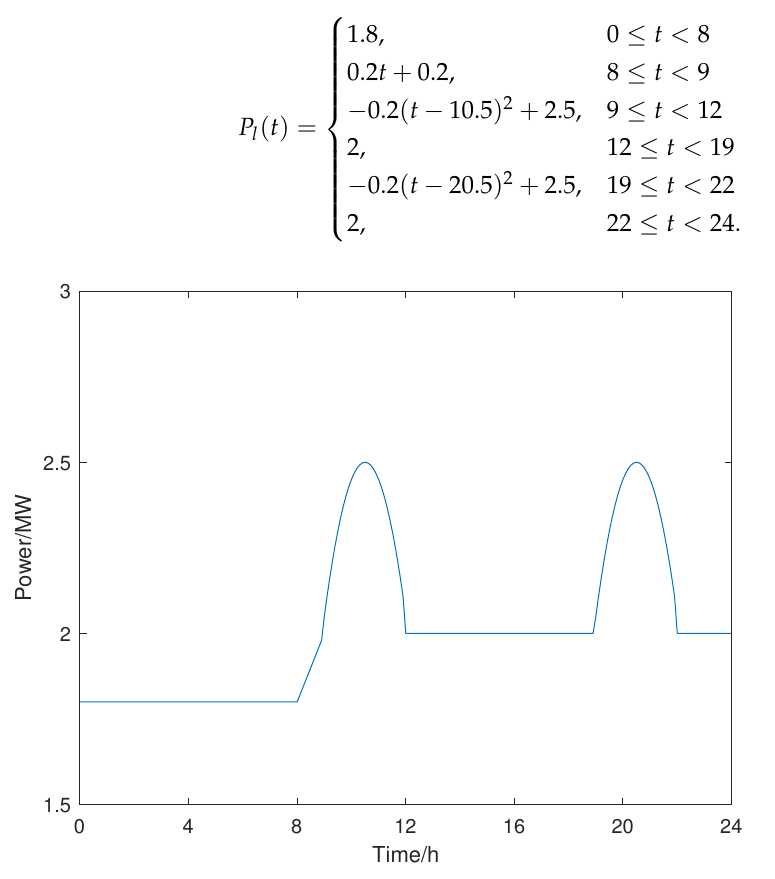
Figure 5. Electric load during a day.